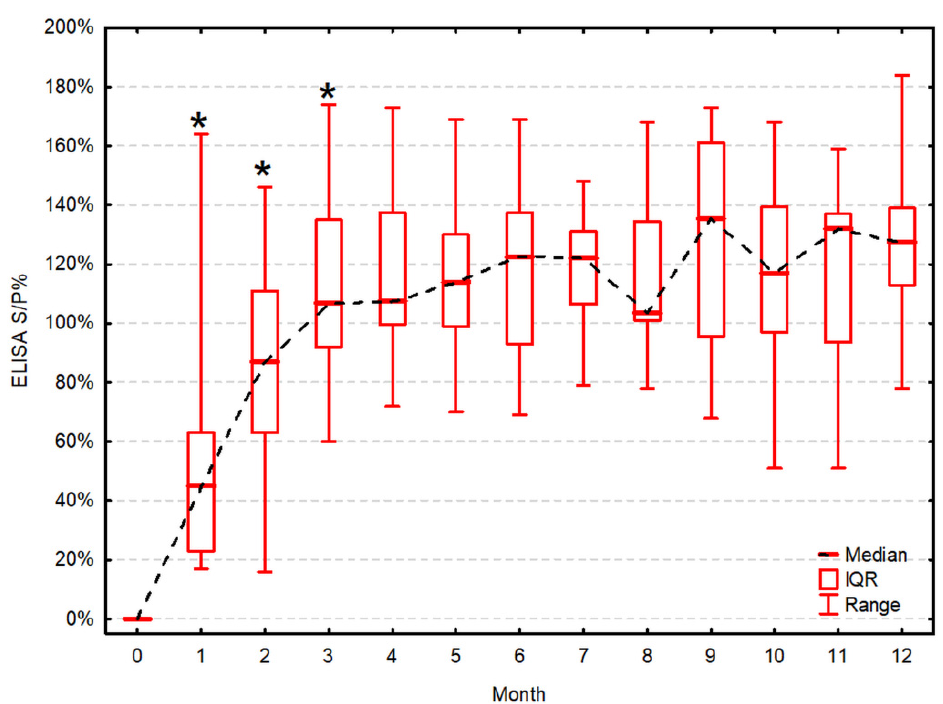
Figure 2. Sample-to-positive control ratio (S/P%) in ELISA during 12 months post-vaccination. S/P% in ELISA are presented as the median, IQR and range. Asterisk (*) indicates a statistically significant increase of the titer compared to the previous one ( α = 0.05).